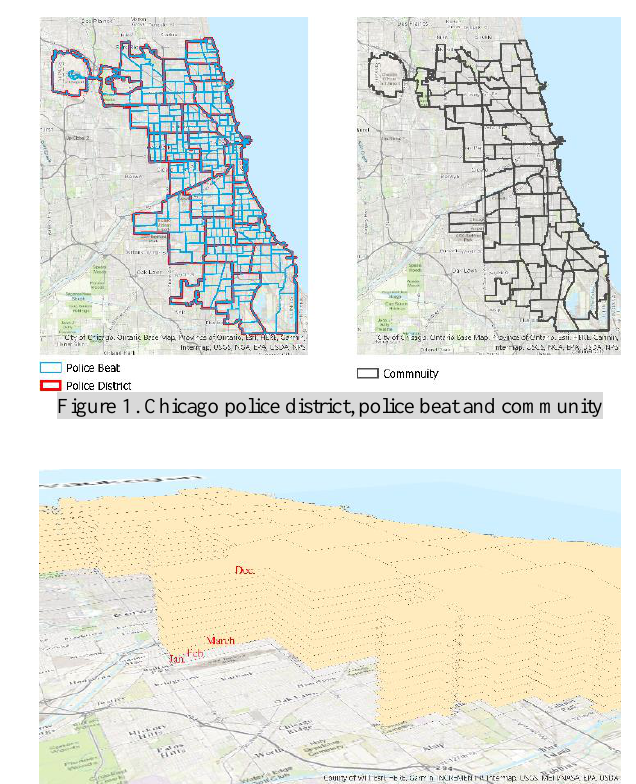
Figure 2. Spatiotemporal data slice of police districts at monthly temporal